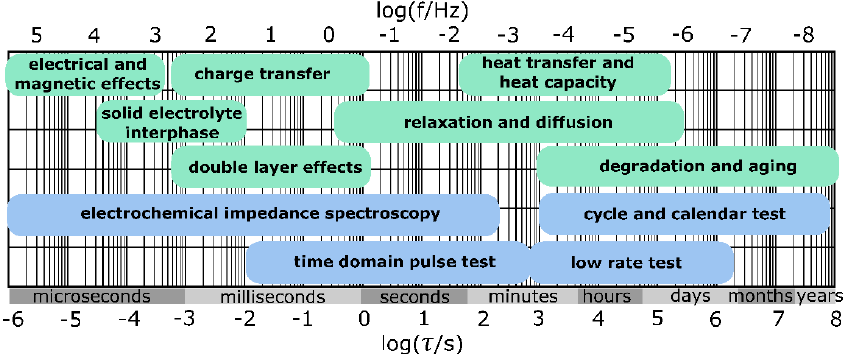
Figure 1. Dynamic, frequency dependent processes of an electrochemical system (in green) and battery test methods (in blue) with typical ranges of characteristic time constants.